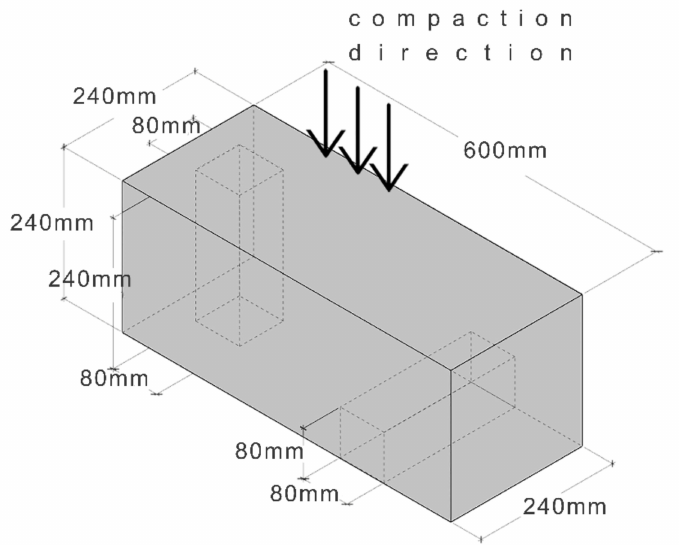
Figure 3. The method of cutting out samples for testing the capillary